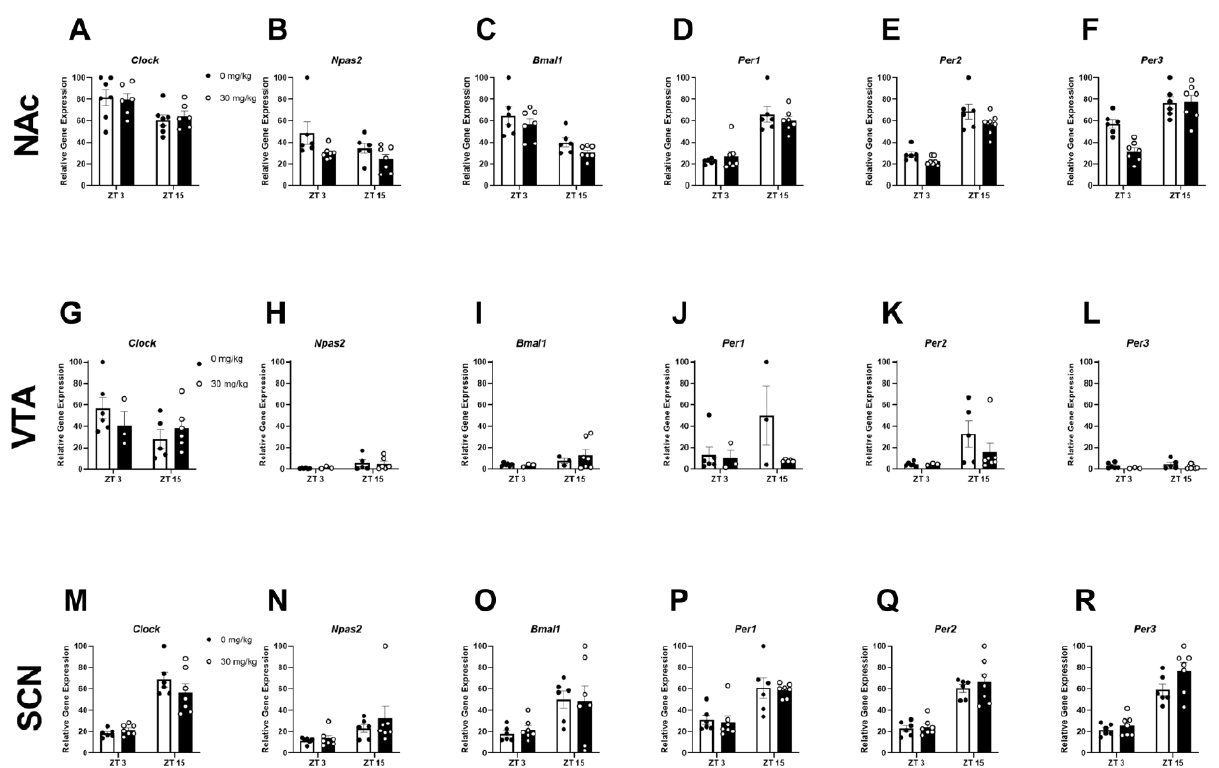
Figure 3. Inhibiting CK1E/D with PF-670462 treatment reduces NAc circadian gene expression in female HDID-1 mice. The following core circadian genes— Clock , Npas2 , Bmal1 , Per1 , Per2 , Per3 —